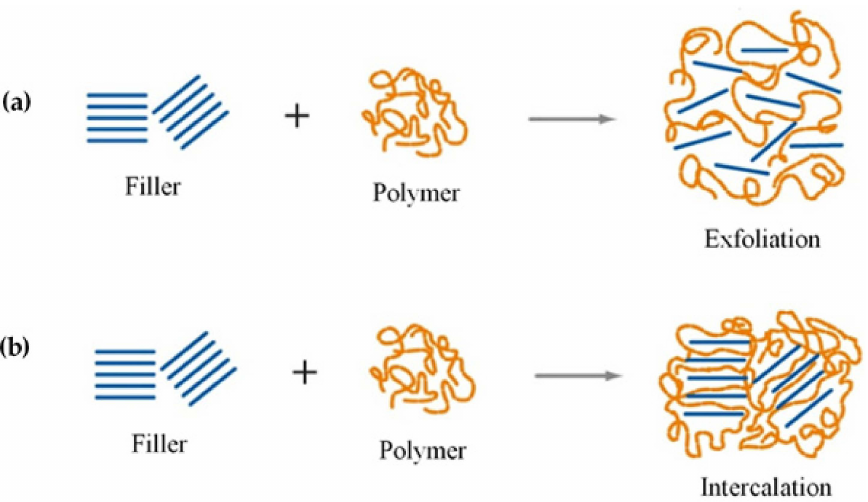
Figure 8. Representation of filler ( a ) exfoliation and ( b ) intercalation within the polymer matrix. Repro- duced with permission from Mater. Sci. Eng. R Reports , 28 , Alexandre and Dubois, Polymer-layered silicate nanocomposites: Preparation, properties and uses of a new class of materials, 1–63, 2000